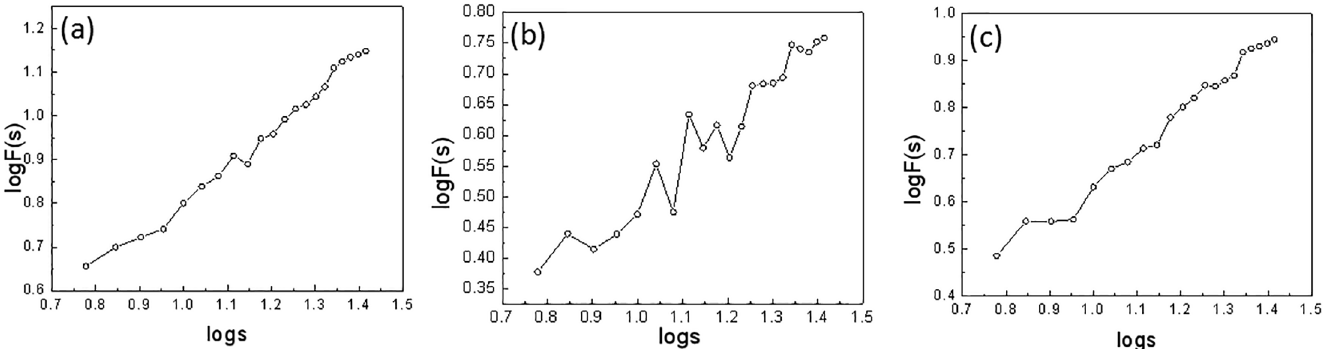
Fig 6. The long-range correlation of the annual mean temperatures from 1909–2014 for the stations at (a) Harbin; (b) Changchun; (c) Shenyang.